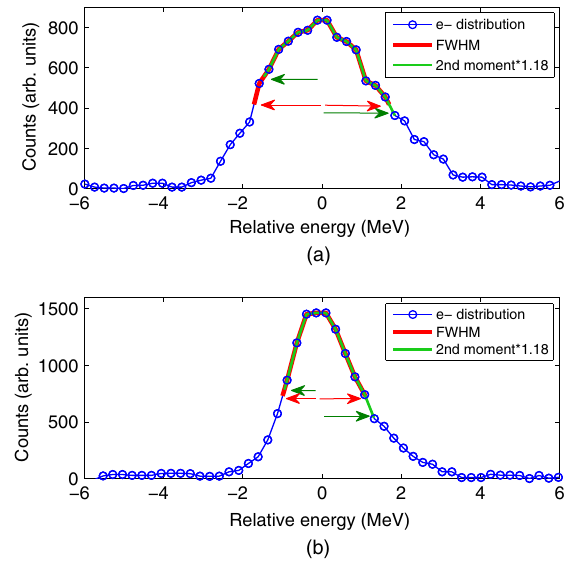
FIG. 18. Method used to determine the SES with the XTCAV. Examples given for a 0.5 kA beam with laser heater set to induce energy spread of 8 keV (a) and 30 keV (b). An individual lineout (blue line with circles) is taken from the XTCAV image (e.g., Fig. 15), and either the fwhm (red lines/arrows) or the second moment (green lines/arrows) are determined from the lineout. The second moment is calculated individually for the left- and right-hand sides of the distribution, and then scaled by a factor of 1.18 to match the fwhm, assuming a Gaussian distribution. On the right side, the low shoulder biases the rms metric to give a larger energy spread.